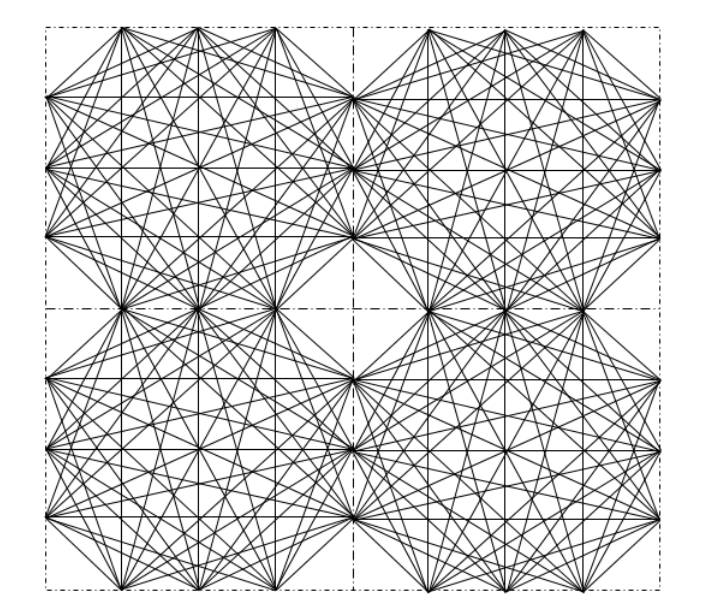
Figure 1. Example of element and possible ray path. Dashed lines: element boundaries. Solid lines: node